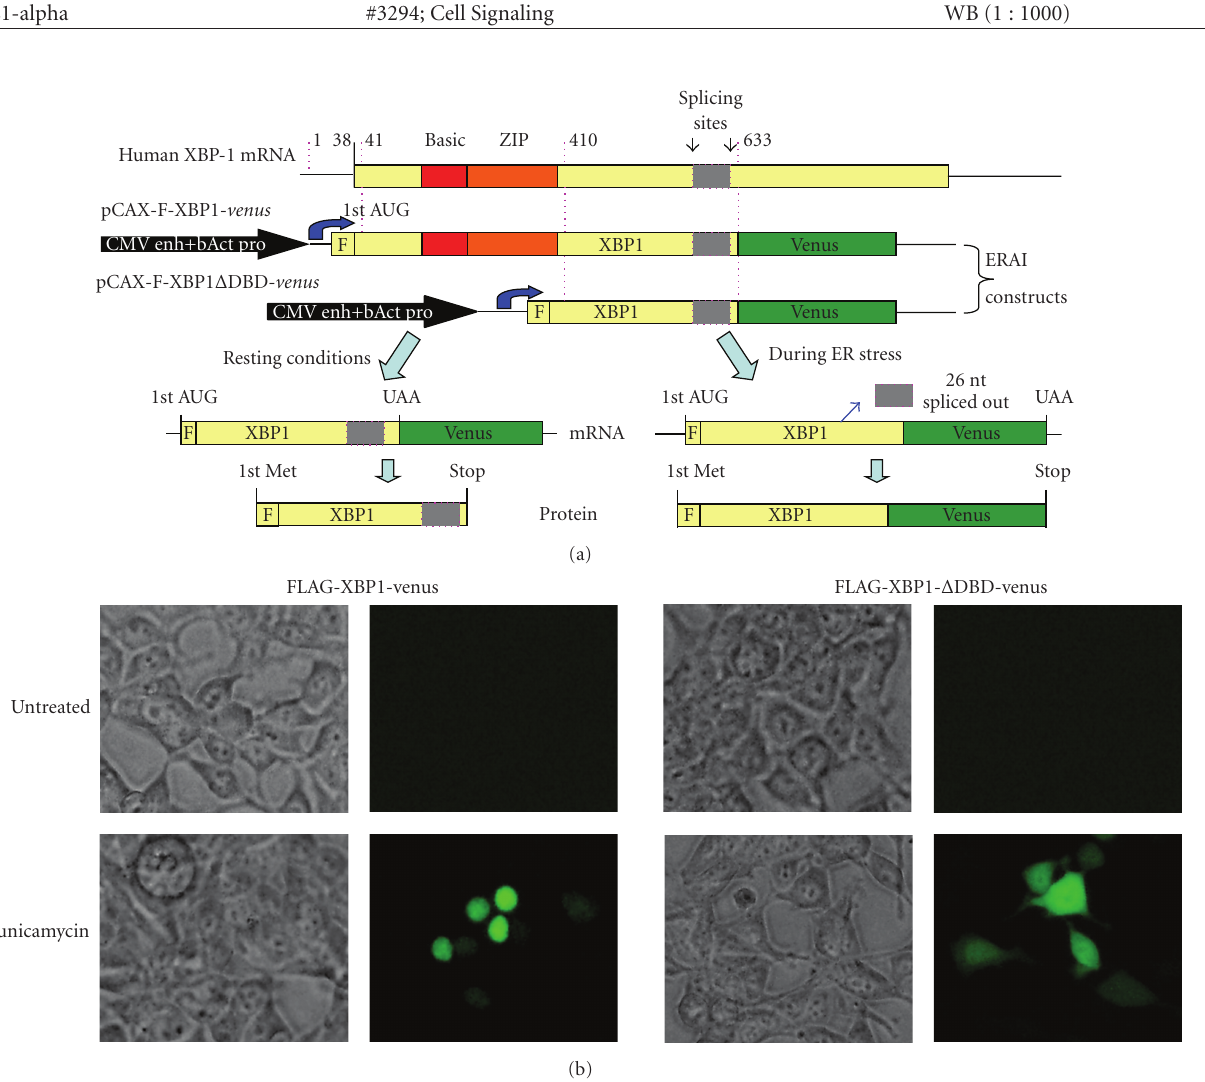
Figure 3: Detection of IRE1 activity using “ER stress-activated indicator” (ERAI) constructs. (a) Schematic presentation of ERAI plasmid obtained by fusing XBP1 and venus , a variant of the green fluorescent protein (adapted from [36] by Iwawaki et al. (2004)). (b) Twenty-four hours after transfection F-XBP1- venus and F-XBP1 Δ DBD- venus ,293T cells were left untreated or treated with(1 μ g/mL) tunicamycin for 24 hours and then analyzed by fluorescence